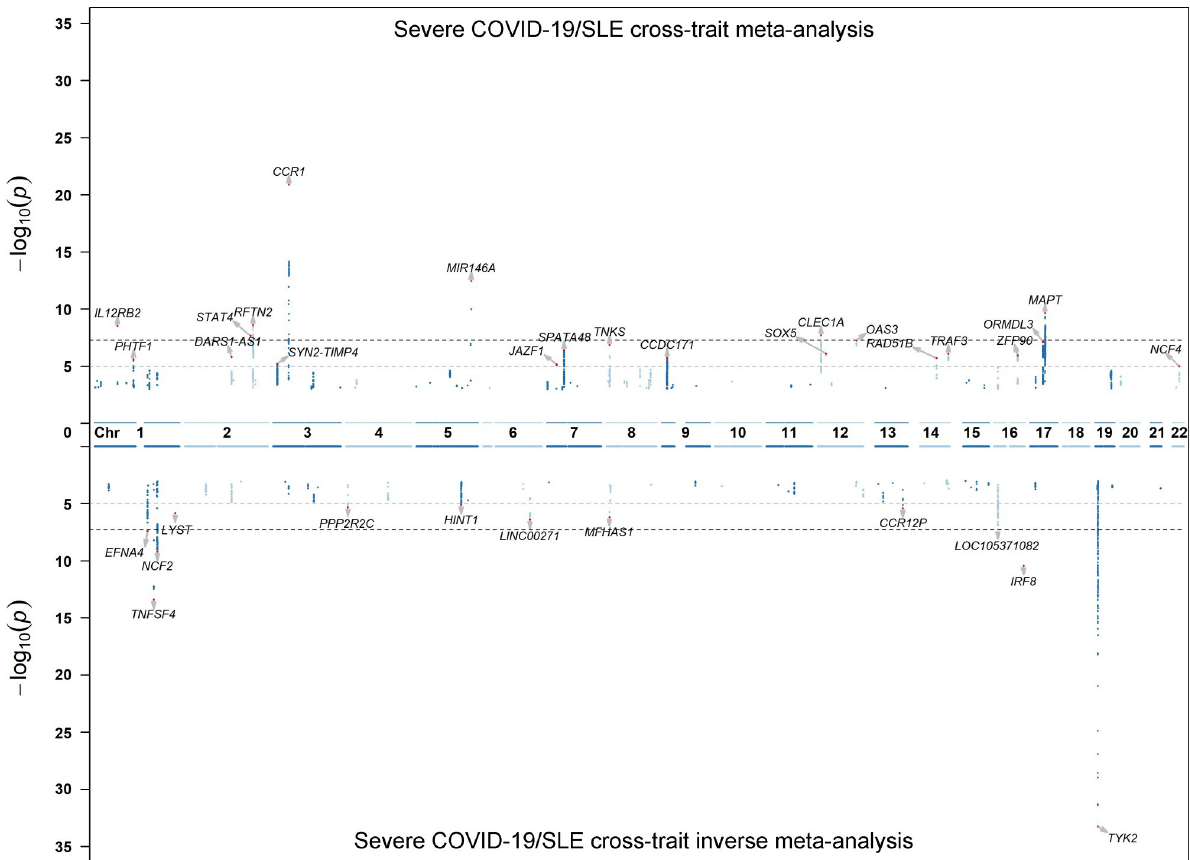
Fig 2. Cross-trait meta-analysis log10 p-values. Upper plot has results from a standard inverse variance meta-analysis. The lower plot has results form a meta-analysis when reversing the severe COVID-19 direction of effect. The MHC extended region (chr6: 24–36 Mb) was removed. Signals that the lead SNP has p-values < 1 x 10 − 05 were annotated by the closest gene names according to base pair